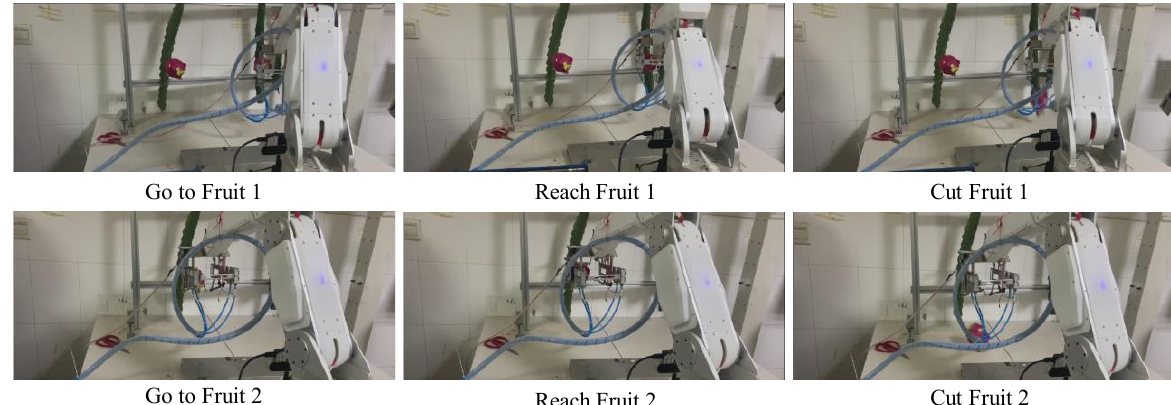
Figure 11. The process of picking dragon